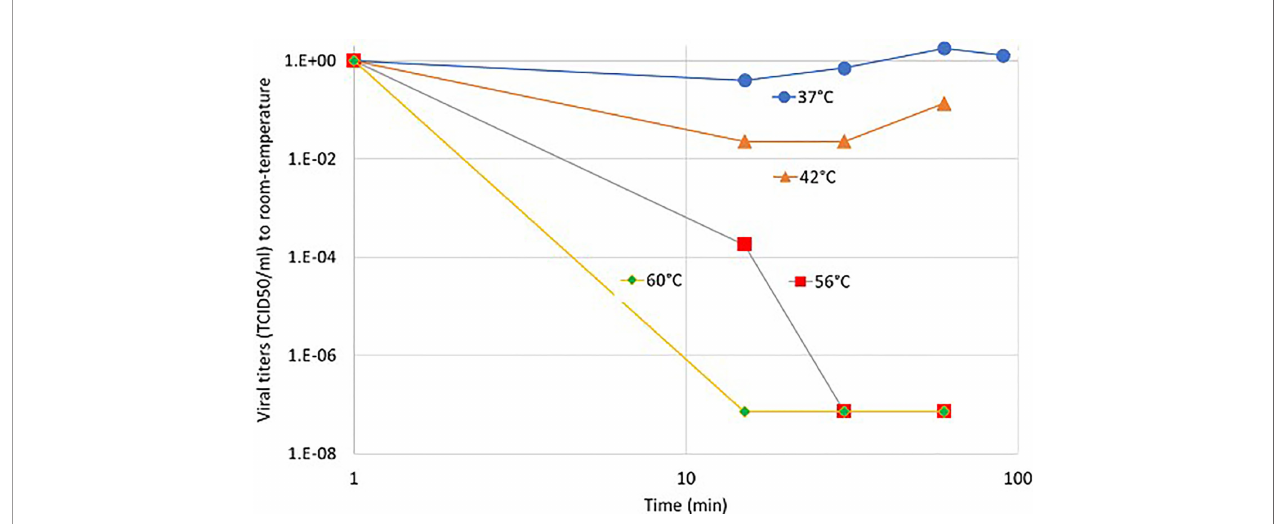
FIGURE 4 | The relative variation of the viral titers (TCID50) of sputum by temperature compared to